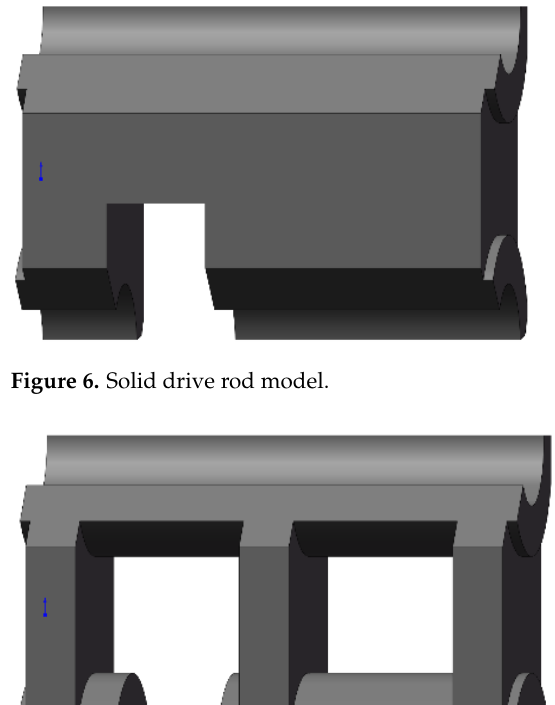
Figure 9. Stress of solid drive rod. Figure 10. Deformation of hollow drive rod.